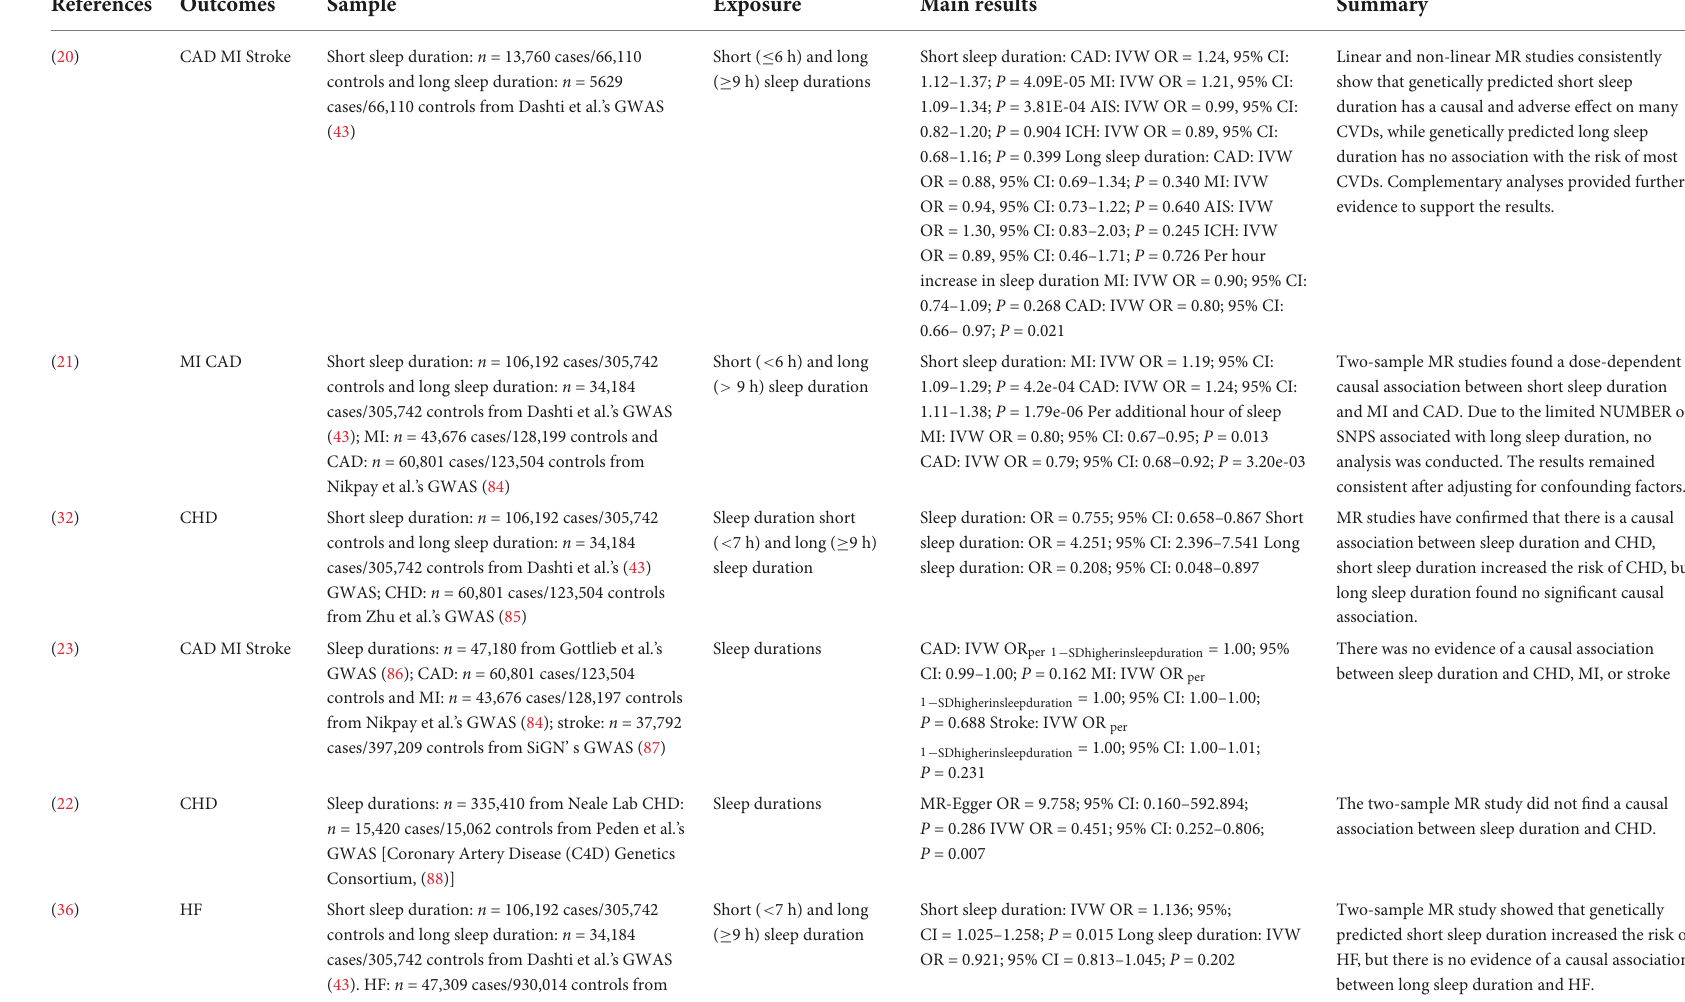
TABLE 2 Causal relations of sleep duration and cardiovascular diseases in Mendelian randomization